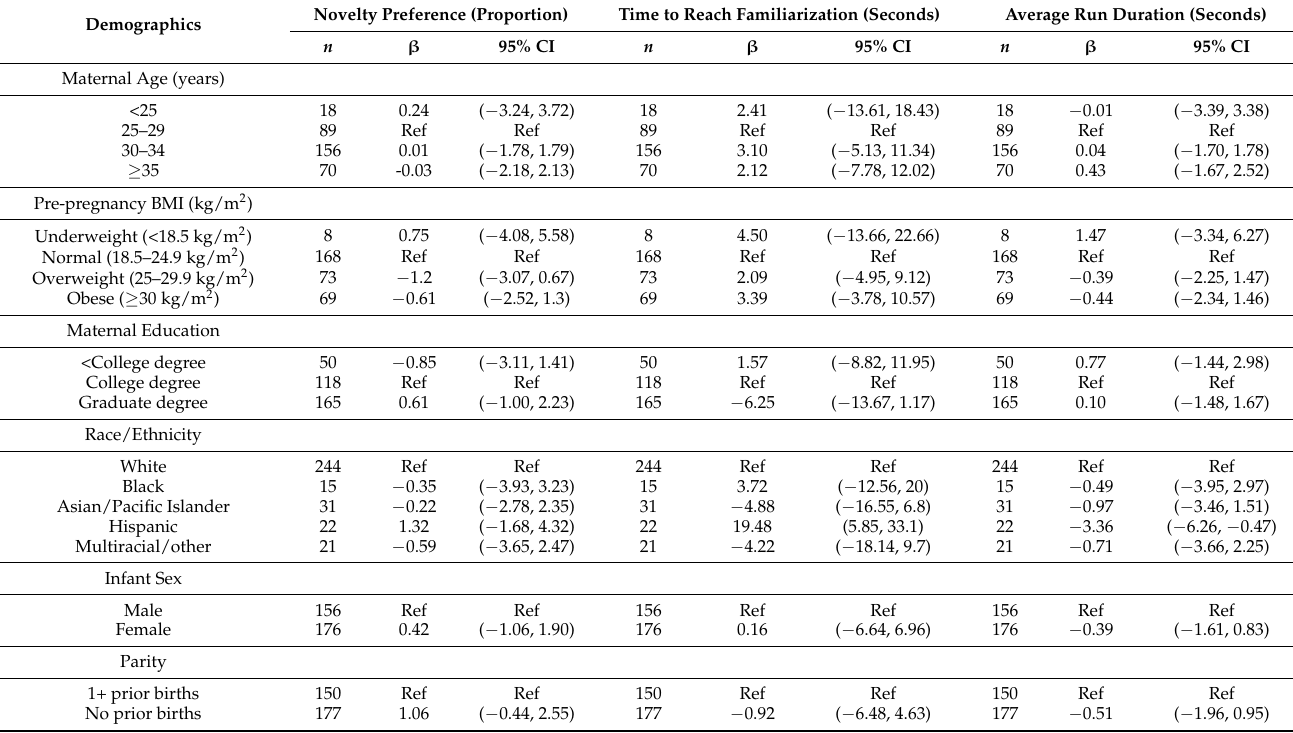
Table 4. Unadjusted associations between demographic characteristics and visual recognition memory (VRM) outcomes in total ECHO.CA.IL